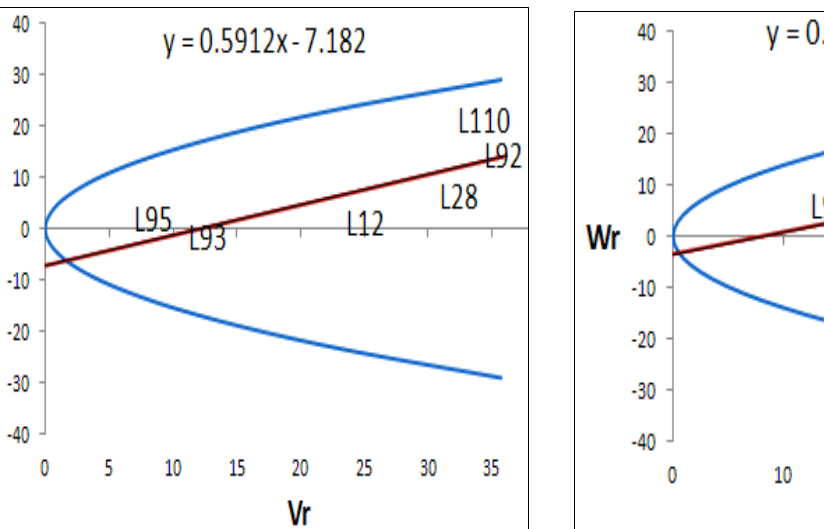
Fig. 7a: Wr/Vr graphs forseed weight per plant under NI Fig. 7b: Wr/Vr graphs forseed weight per plant under